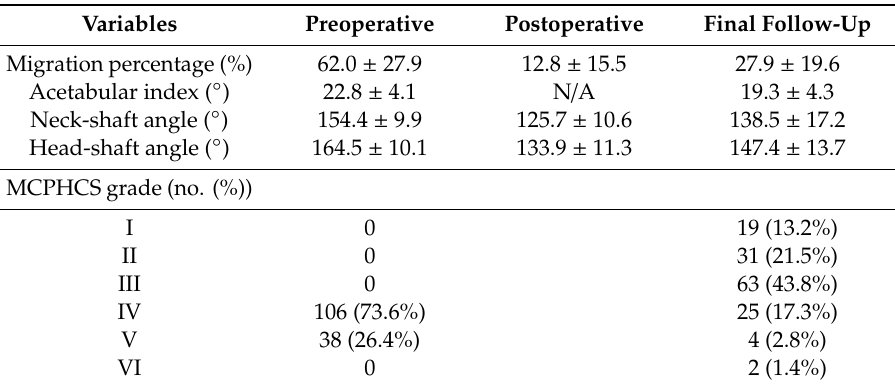
Table 2. Radiological measurements.